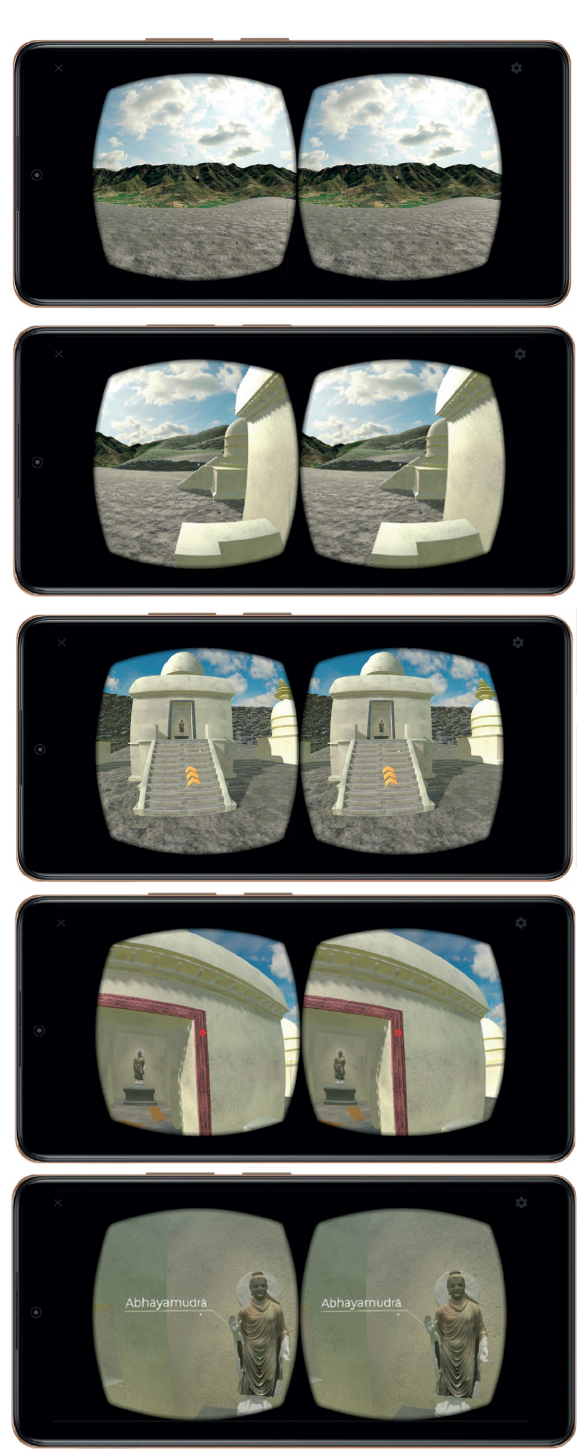
Figure 16 . Steps of VR